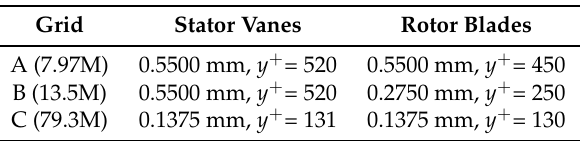
Table 1. Averaged smallest wall-normal spacing and y + value for three grids along the blade/vane surface operating at design